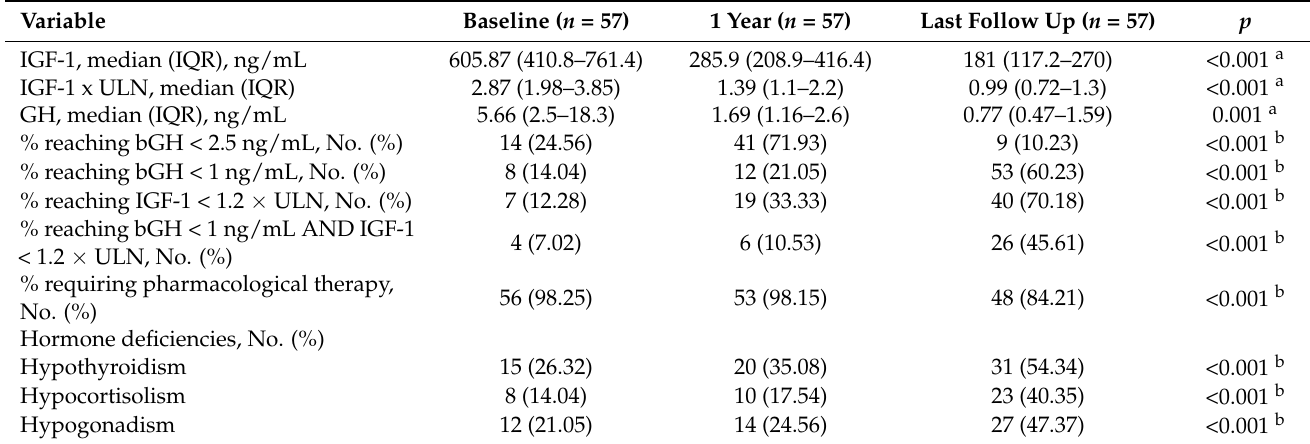
Table 2. Analysis of the evolution of hormonal parameters and deficiencies of the hypothalamus- pituitary axis at the baseline, at year and at the end of follow-up ( n = 57).